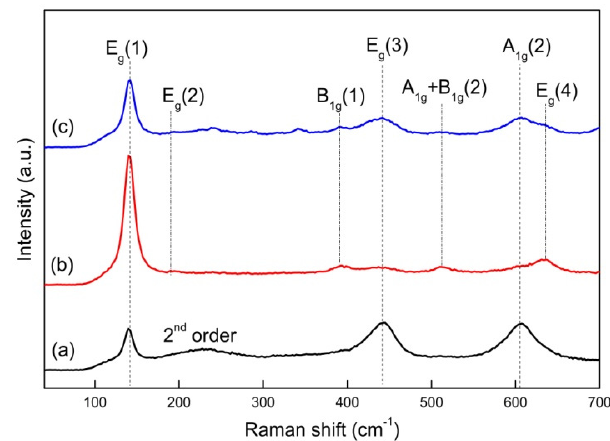
Figure 5. Raman spectra of ( a ) pristine TiO 2 , ( b ) 3 wt.% Ni-doped TiO 2 , and ( c ) 6 wt.% Ni-doped TiO 2 .